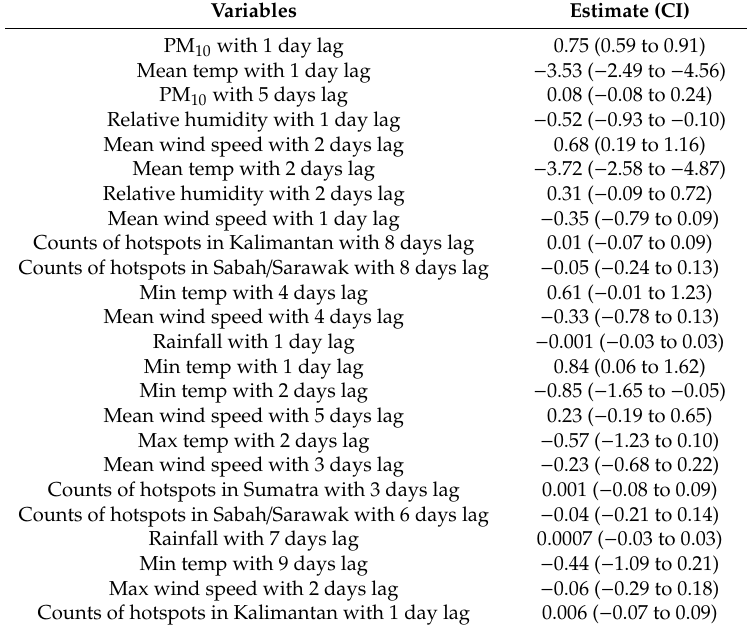
Table 2. Coe ffi cients for variables associated with PM 10 that are significant ( p < 0.05) using VAR